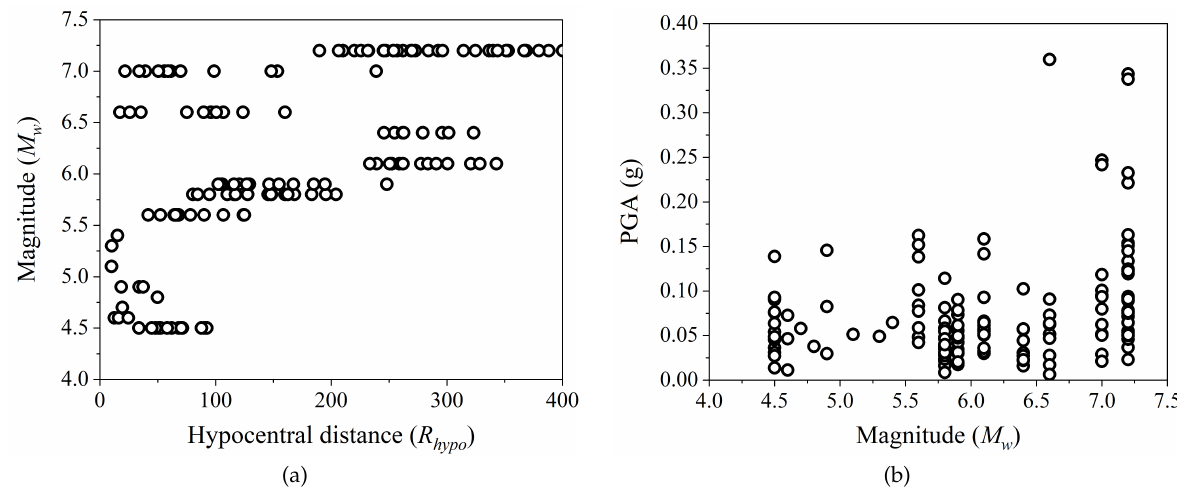
Fig. 4. Ground motion records used in the present study, (a) magnitude versus hypocentral distance, (b) PGA versus magnitude.